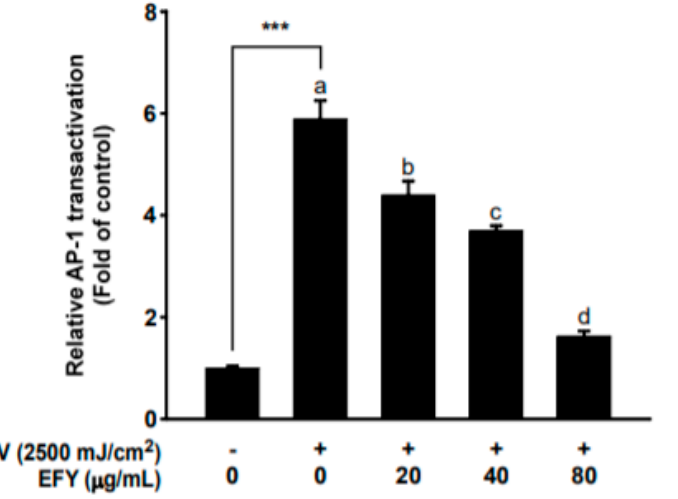
Figure 3. EFY suppresses sUV-induced transactivation of AP-1 in HaCaT cells. Data ( n = 3) are mean values ± SD. *** significant difference ( p < 0.001) between the control and sUV-exposed control. Mean values with different letters indicate statistically significant differences among sUV-exposed groups ( p < 0.05).